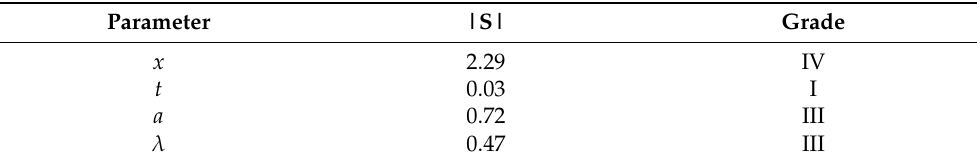
Figure 5. Variations in the relative temperature u ( x , t ) with variations in other parameters. Table 4. Sensitivity of t j in relation to other